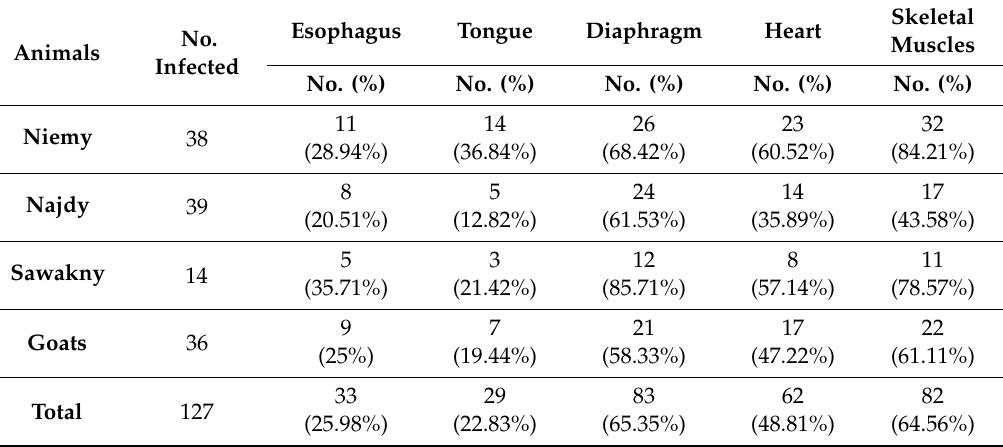
Table 4. Organ distribution of Sarcocystis species in sheep and